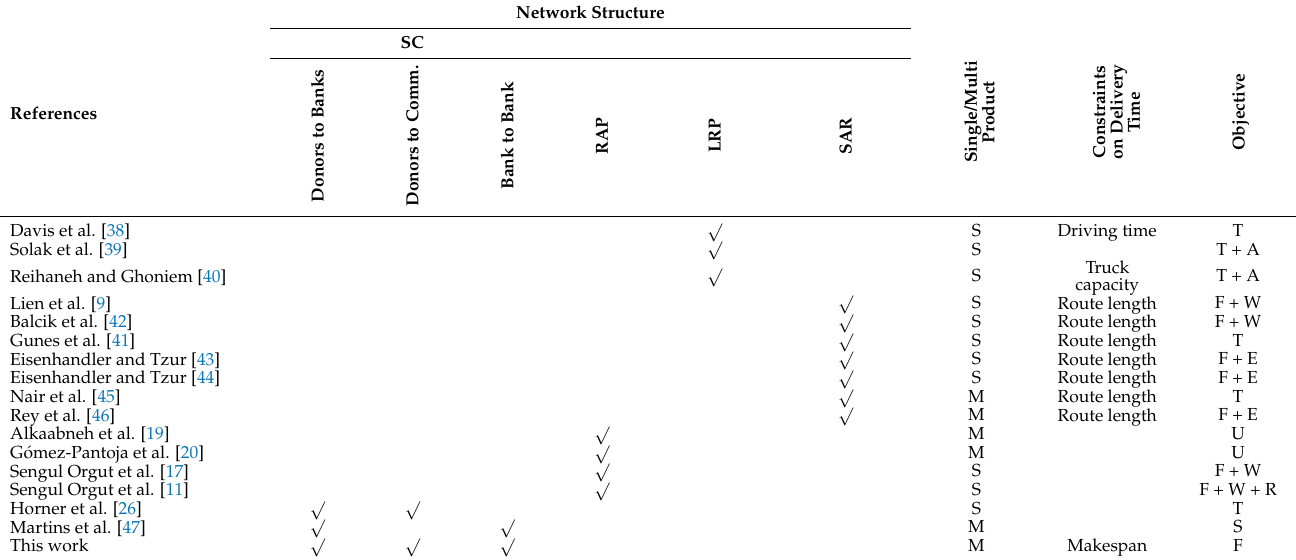
Table 1. Main attributes of reviewed papers presenting food aid distribution models. Network